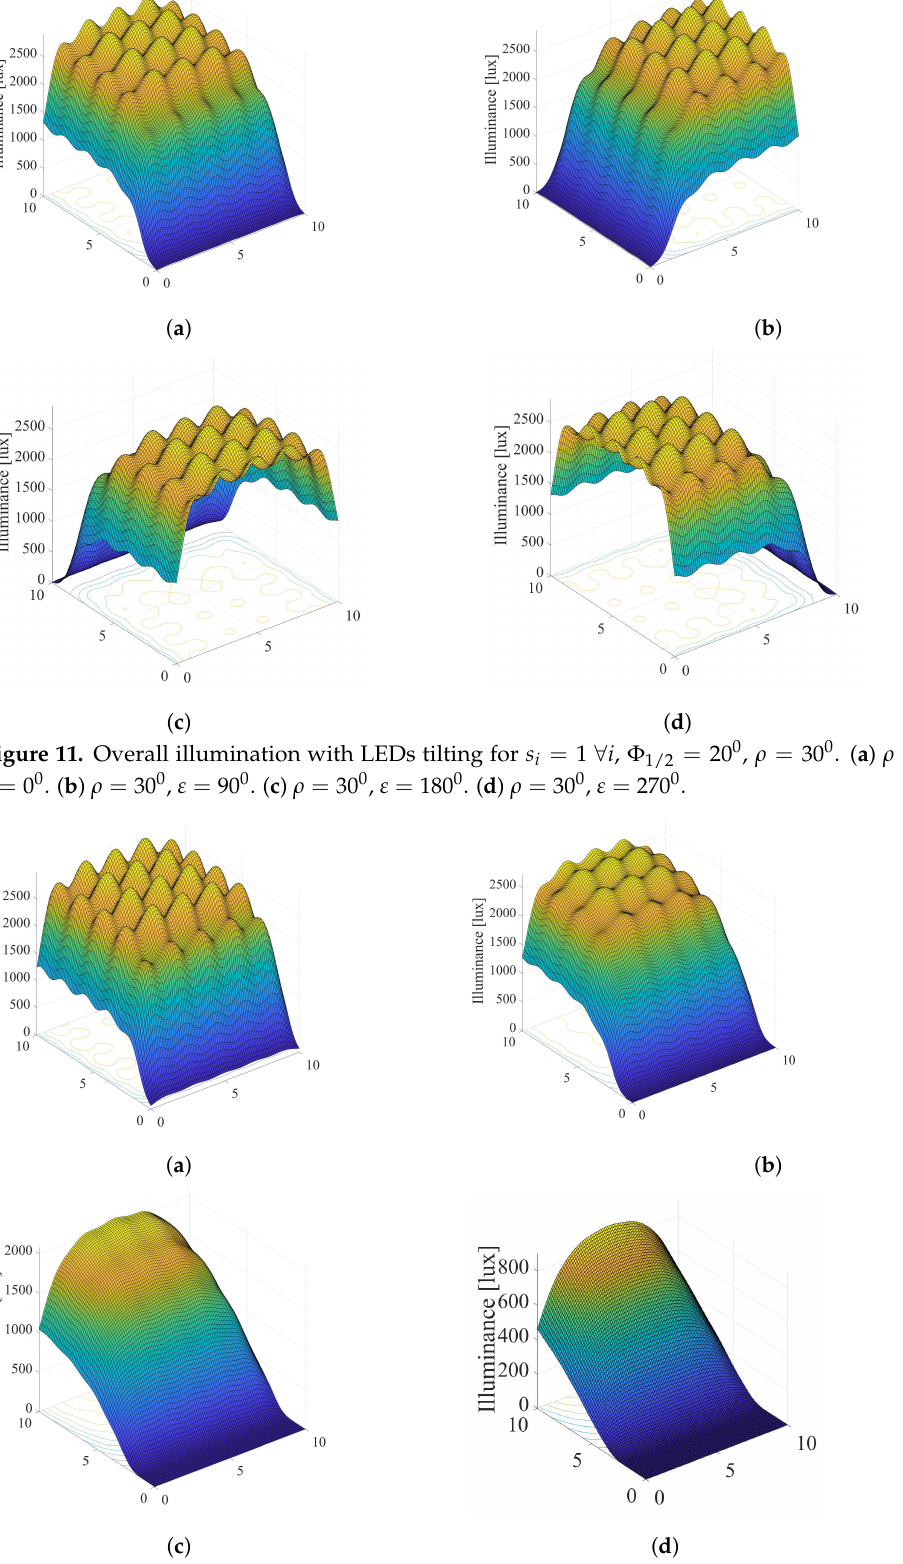
Figure 12. Overall illumination with LEDs tilting for s i = 1 ∀ i , Φ 1/2 = 20 0 , ε = 0 0 . ( a ) ρ = 20 0 , ε = 0 0 . ( b ) ρ = 40 0 , ε = 0 0 . ( c ) ρ = 60 0 , ε = 0 0 . ( d ) ρ = 80 0 , ε = 0 0